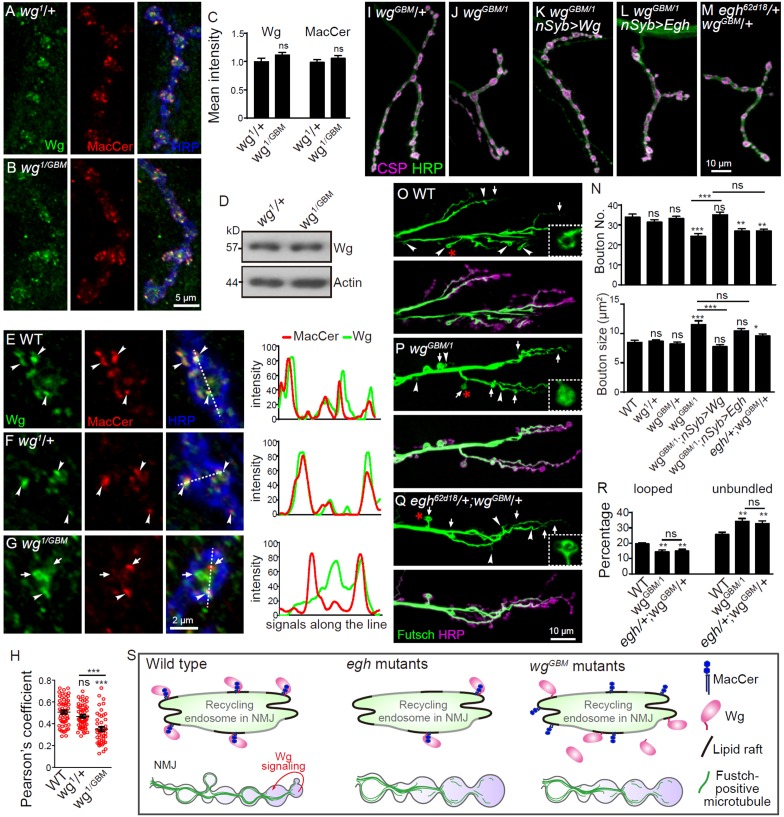
Wg GBM is required for Wg-MacCer colocalization and NMJ growth.(A and B) Representative images of NMJ4 co-labeled with anti-Wg (green), anti-MacCer (red) and anti-HRP (blue) in wg1/+ (A) and wgGBM/wg1 mutants (B). (C) Quantification of Wg and MacCer intensities normalized to HRP intensities in different genotypes. n ≥ 15 larvae; ns, no significance by one-way ANOVA with Tukey post hoc tests; error bars: s.e.m. (D) Western results of Wg and Actin from 3rd instar larvae of wg1/+and wgGBM/wg1 mutants. Actin was used as a loading control. Western blots were performed in triplicate and a representative image is shown. (E–G) Representative images of NMJ4 boutons triple-labeled with anti-Wg (green), anti-MacCer (red) and anti-HRP (blue) in wild type (E), wg1/+ (F) and wgGBM/wg1 mutants (G). Arrowheads indicate puncta positive for both MacCer and Wg signals; arrows indicate puncta without obvious overlap of MacCer and Wg. Images were processed by deconvolution. Scale bar: 2 μm. Plot profiles of relative intensity of MacCer and Wg along the dashed lines were shown. (H) Pearson’s coefficients of colocalization between MacCer and Wg. n = 58/10, 57/8, and 46/8 (from left to right, boutons/animals). ns, no significance, ***p<0.001 by one-way ANOVA with Tukey post hoc tests; error bars: s.e.m. (I–M) Representative images of NMJ4 co-stained with anti-HRP (green) and anti-CSP (magenta) in wgGBM/+ (I), wgGBM/wg1 (J), UAS-Wg-HA, wgGBM/wg1; nSyb-Gal4/+ (K), UAS-Egh, wgGBM/wg1; nSyb-Gal4/+ (L), and egh62d18/+; wgGBM/+ (M). Scale bar: 10 μm. (N) Quantifications of bouton number and bouton size of NMJs in different genotypes. n ≥ 12 larvae; ns, no significance, *p<0.05; **p<0.01; ***p<0.001 by one-way ANOVA with Tukey post hoc tests, error bars: s.e.m. (O–Q) Representative images of NMJ6/7 labeled with anti-Futsch (green) and anti-HRP (magenta) in wild type (O), wgGBM/wg1 (P), and egh62d18/+; wgGBM/+ transheterozygotes (Q). Insets show higher magnification images of Futsch staining of a single bouton (asterisk). Arrows indicate boutons displaying unbundled Futsch; arrowheads denote boutons with Futsch loops. Scale bar: 10 μm. (R) Quantifications of percentage of Futsch loops and unbundled Futsch staining in different genotypes. n ≥ 12 larvae; ns, no significance, **p<0.01 by one-way ANOVA with Tukey post hoc tests, error bars: s.e.m. (S) A schematic presentation of the role for MacCer in promoting synapse growth via interacting with Wg in lipid rafts. The presynaptic Wg signaling is denoted by a curved arrow.10.7554/eLife.38183.028Figure 9—source data 1.Numerical data for the statistical graphs.